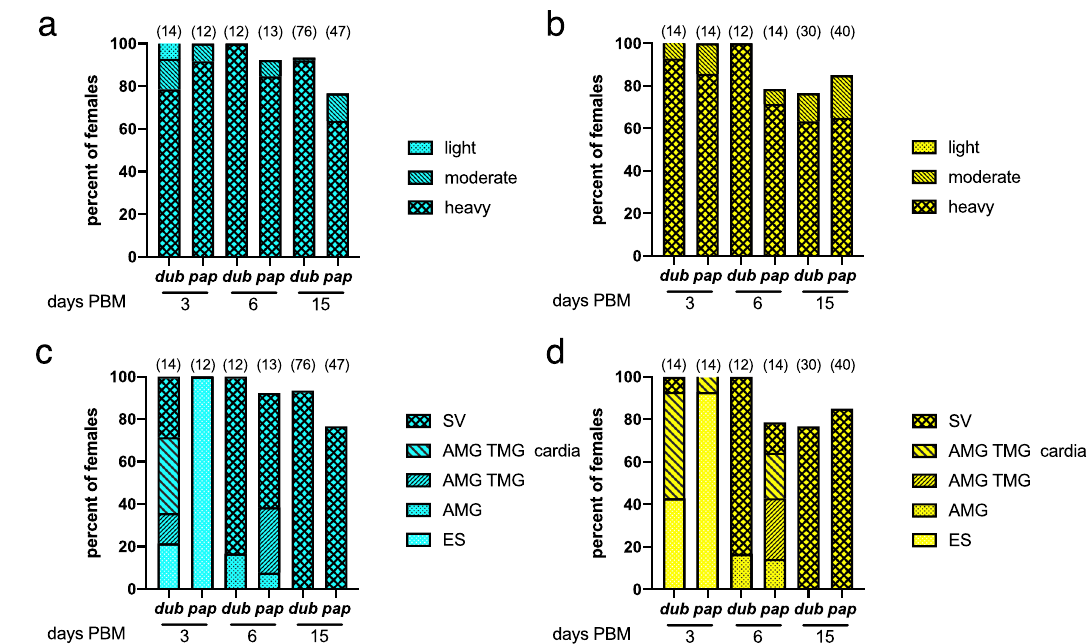
Fig. 5 Qualitative analysis of L. major MRC-01 and L. major MRC-02 development in sand fl ies. At the days indicated post blood meal (PBM), engorged P. duboscqi ( dub ) and P. papatasi ( pap ) were dissected and parasite development was assessed. Percentage of fl ies infected with L. major MRC-01 ( a ) and L. major MRC-02 ( b ) based on assessment of intensity of infection. Development of L. major MRC-01 ( c ) and L. major MRC-02 ( d ) as assessed by location within the gut; endoperitrophic space (ES), anterior midgut (AMG), thoracic midgut (TMG) cardia and stomodeal valve (SV). Data are pooled from three independent experiments and are shown as frequency of total number of sand fl ies dissected. Number of sand fl ies dissected is shown above each bar. Source data are provided as a Source data fi